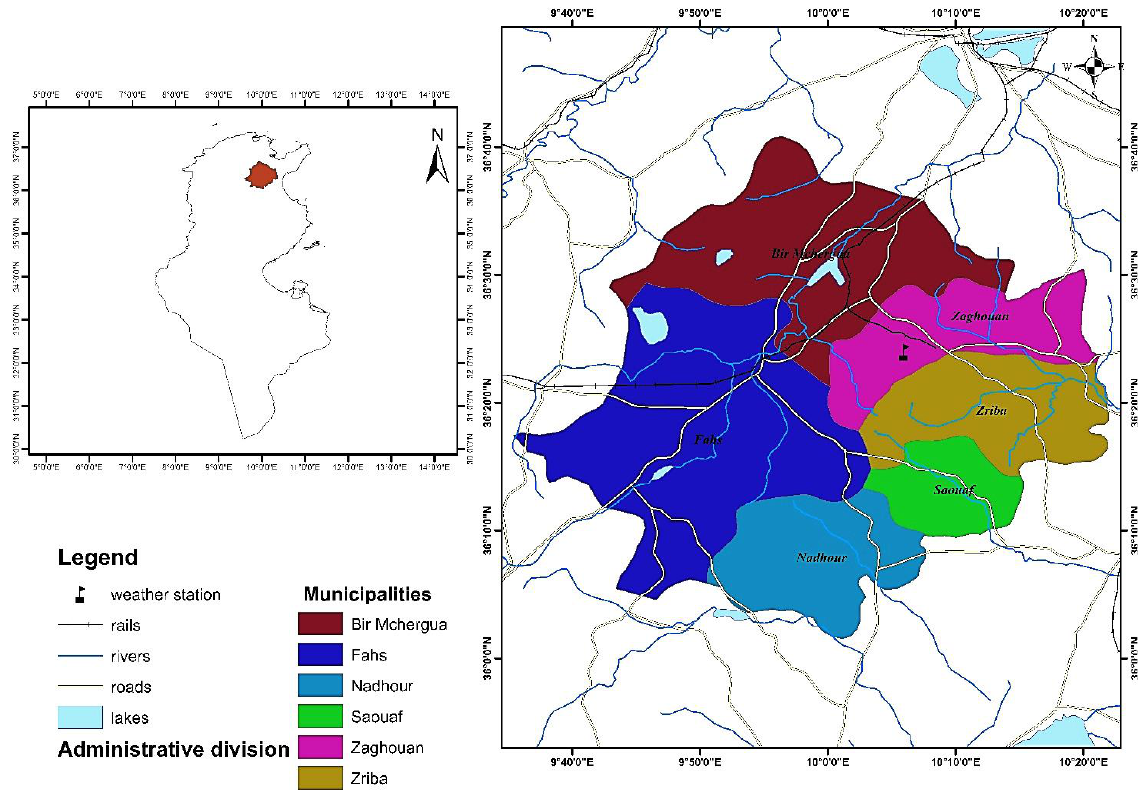
Figure 1. Location of the study area.